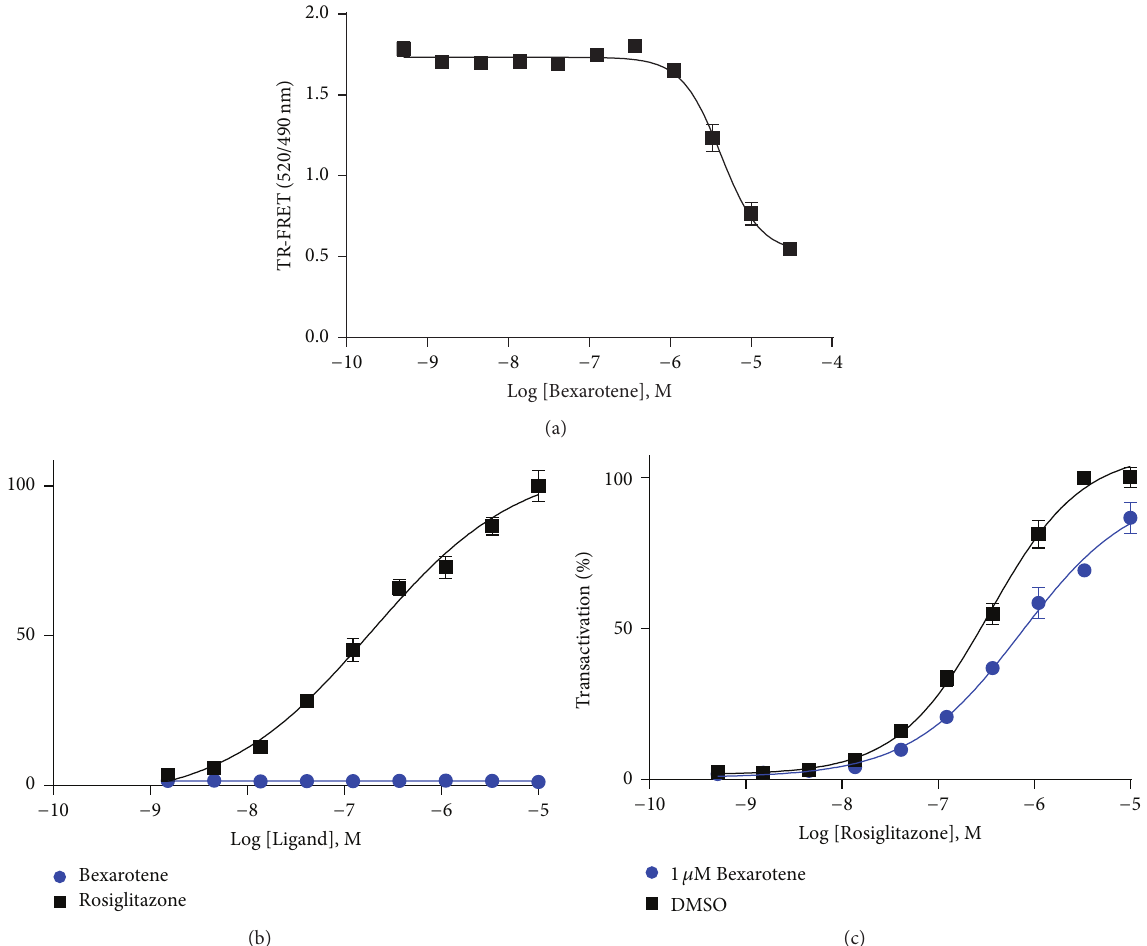
Figure 3: Biochemical characterization of Bexarotene on PPAR 𝛾 : (a) TR-FRET competitive displacement assay ( 𝑛 = 3 ). (b) Dose dependent transcriptional activity of a PPAR 𝛾 :PPRE-luciferase promoter-reporter assay in HEK293T cells ( 𝑛 = 4 ). (c) Dose dependent transcriptional activity of rosiglitazone ± 1 𝜇 M Bexarotene in a PPAR 𝛾 :PPRE-luciferase promoter-reporter assay in HEK293T cells ( 𝑛 = 4